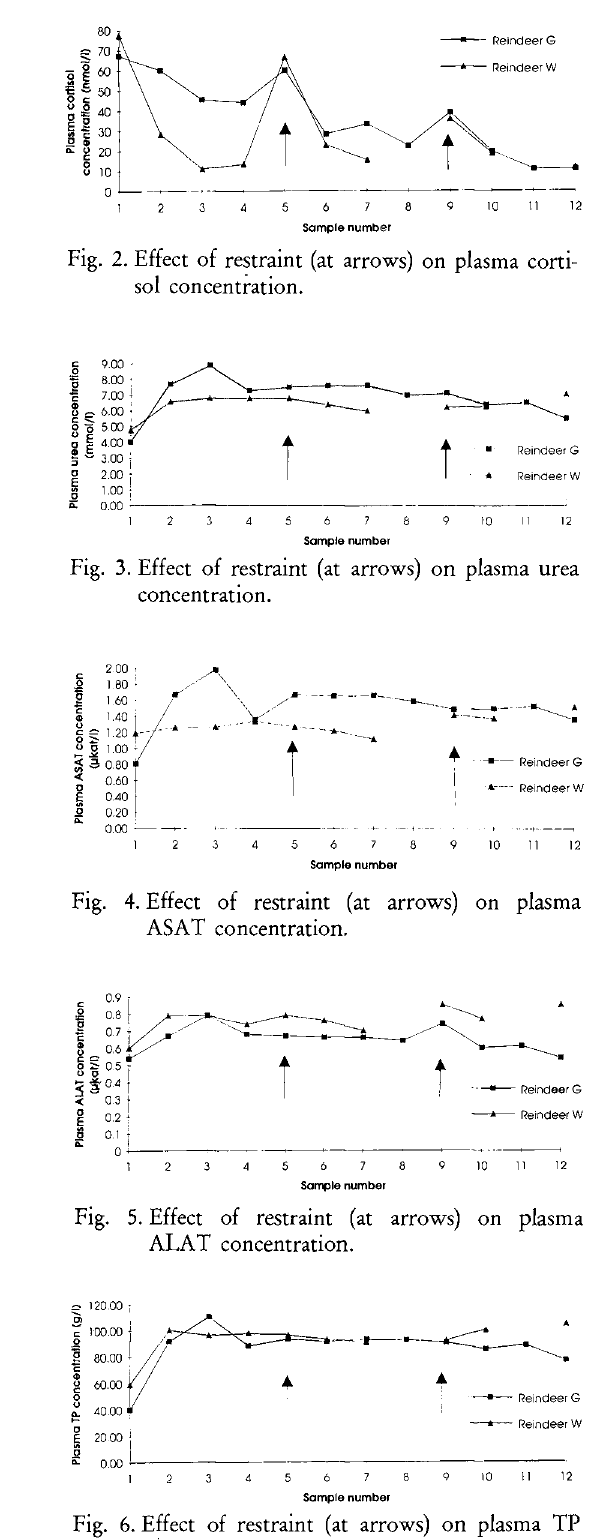
Fig. 6. Effect of restraint (at arrows) on plasma TP